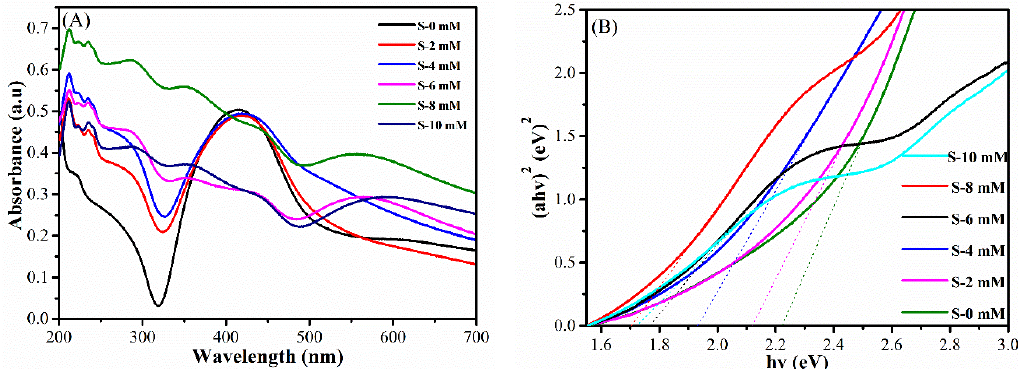
Figure 6. ( A ) UV-VIS absorption spectra of Ag-rGO and the Ag@Cu 2 O-rGO nanocomposites S-2 mM, S-4 mM, S-6 mM, S-8 mM, and S-10 mM; ( B ) the plots of (αhν) 2 vs. photon energy (hν).